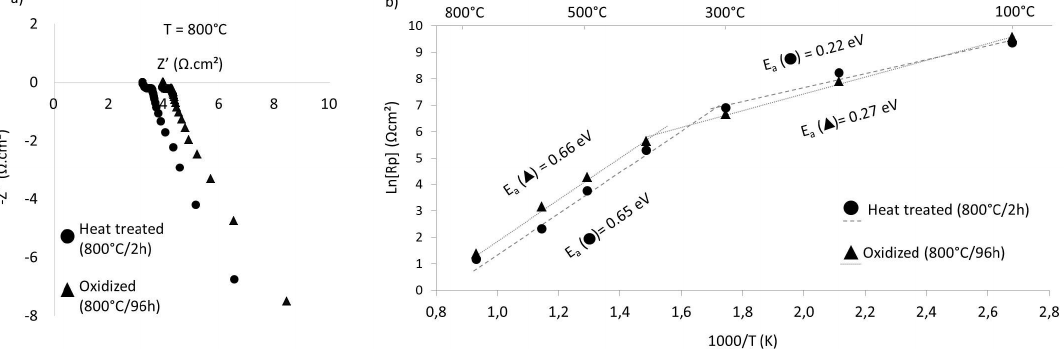
Figure 5. Impedance results for both samples: a) Nyquist diagram at 800°C and b) the Arrhenius